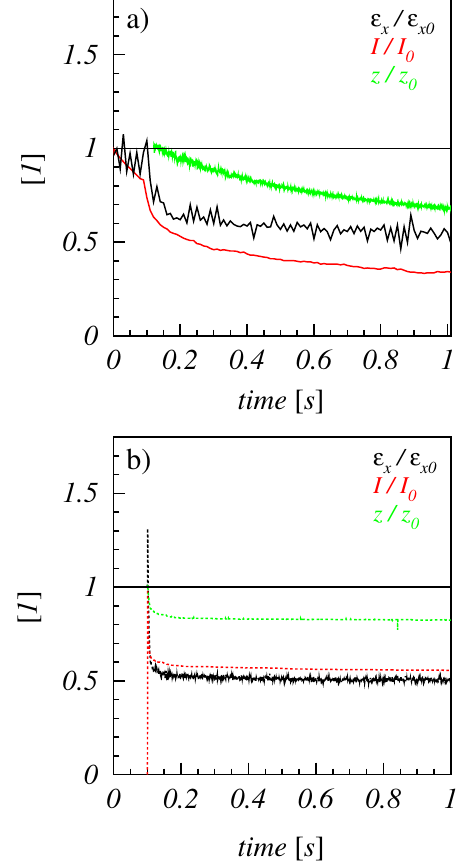
FIG. 18. High intensity bunched beam at Q x ¼ 4 : 3365 . (a) Transverse-longitudinal beam response to the long-term storage. (b) Simulation results for the same working point. The error bars in these measurements (here not shown) are the same as those in Fig.